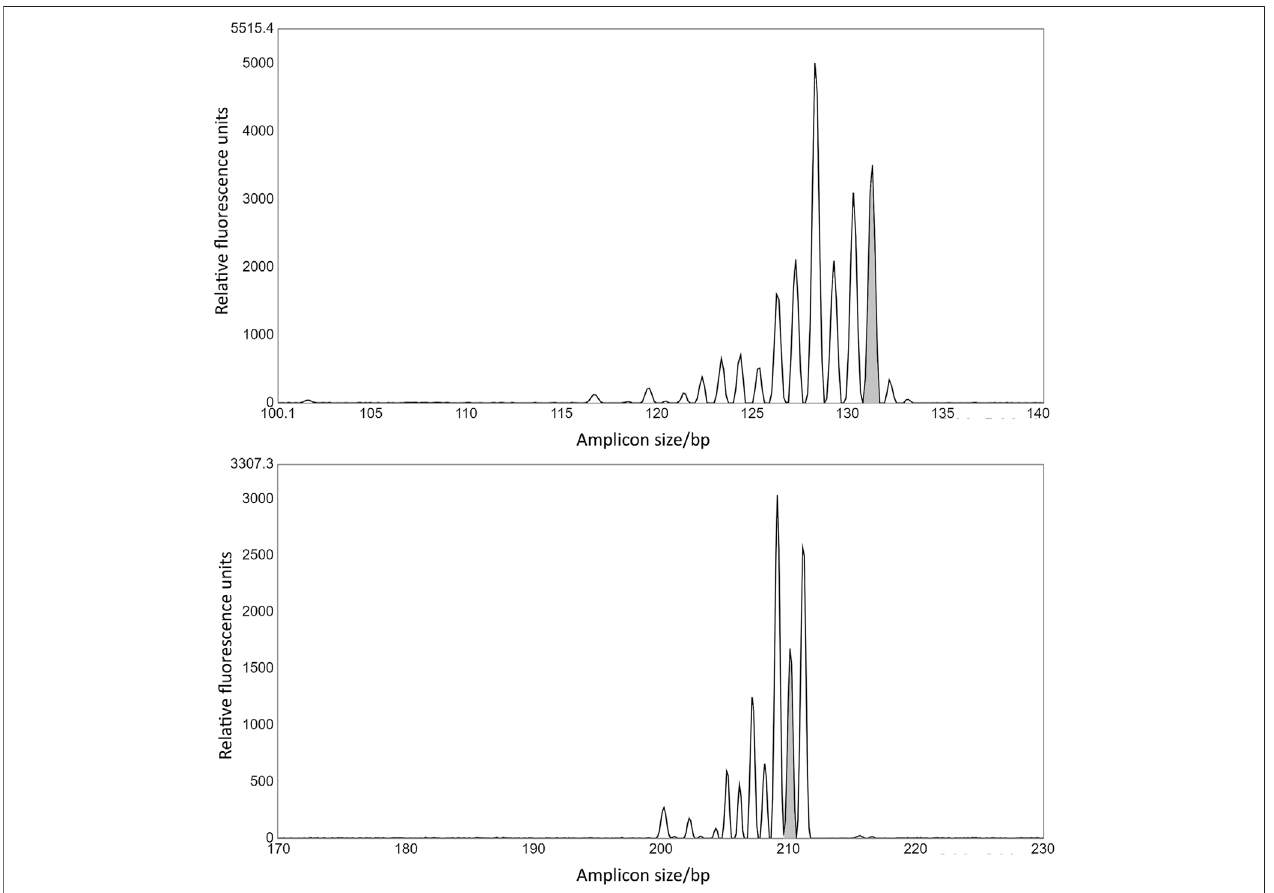
FIGURE 7 | Two DMR6-1 gRNAs confer speci fi c indel patterns . Two different gRNAs targeted at exon 1 in DMR6-1 were transformed into potato protoplasts and editing scored using IDAA. Grey peaks mark the wild-type amplicon. g43 confers aprevalence for a 3bp deletion (upper panel), which in exons do not lead to frameshift of the coding sequence. g45 confers a high incidence of 1 bp indels (lower panel). These patterns were evident in repeated experiments (only data from one experiment shown).gRNA and IDAA primer pairs used: g43 and DMR6 forward primer + DMR6 reverseprimer 2; g45and DMR6 Forward primer 2+ DMR6 Forward primer 4 (see Material and Methods